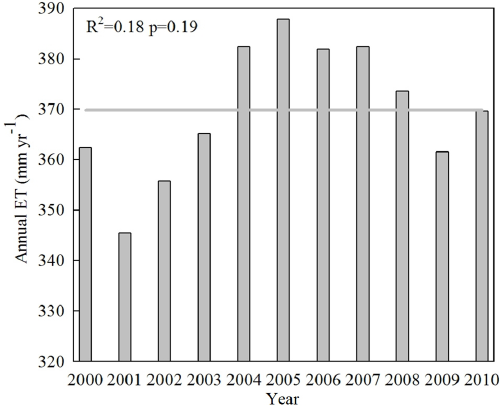
Fig. 10. Interannual variations of annual ET averaged over China’s landmass from 2000 to 2010.